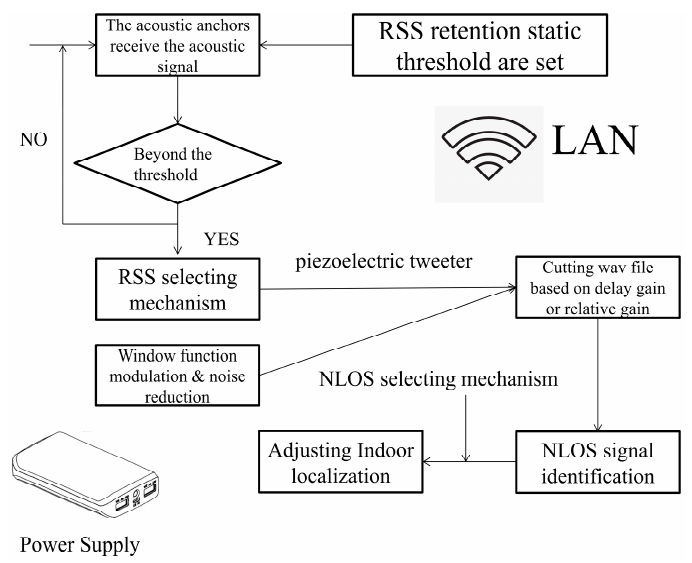
Figure 2. Main process of RSS selection mechanism from [22] of dual-receiving acoustic anchor.